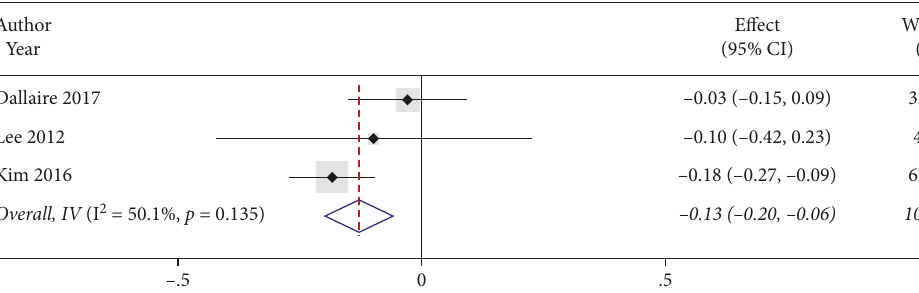
Figure 5: The relative risk of duration of fever identified in the meta-analysis from three enrolled studies.